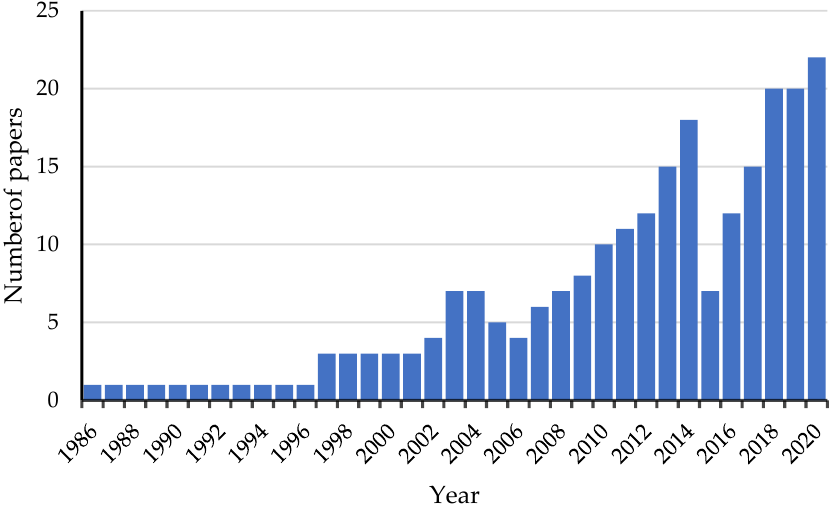
Figure 2. The distribution of composite piles-related publications over time.